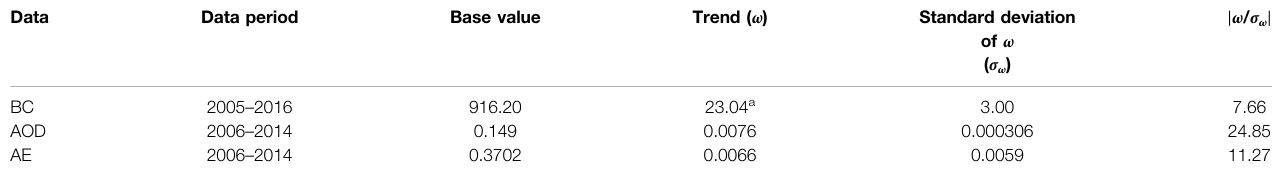
Frontiers in Earth Science |